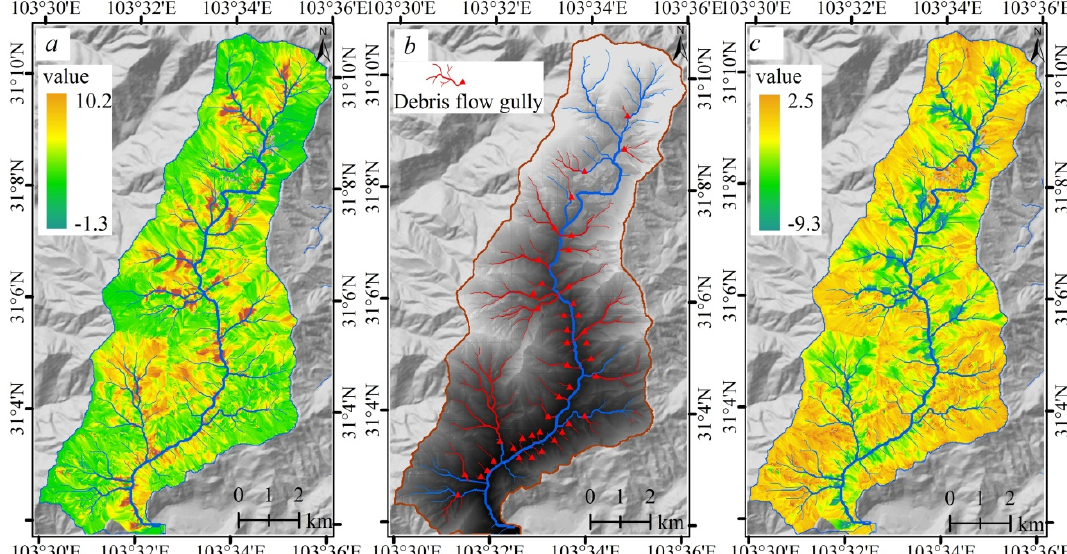
Figure 11. ( a ) SFCI increase map after the earthquake; ( b ) post-earthquake debris flow events; ( c ) SFCI decrease map a few years after the earthquake at the Longxi